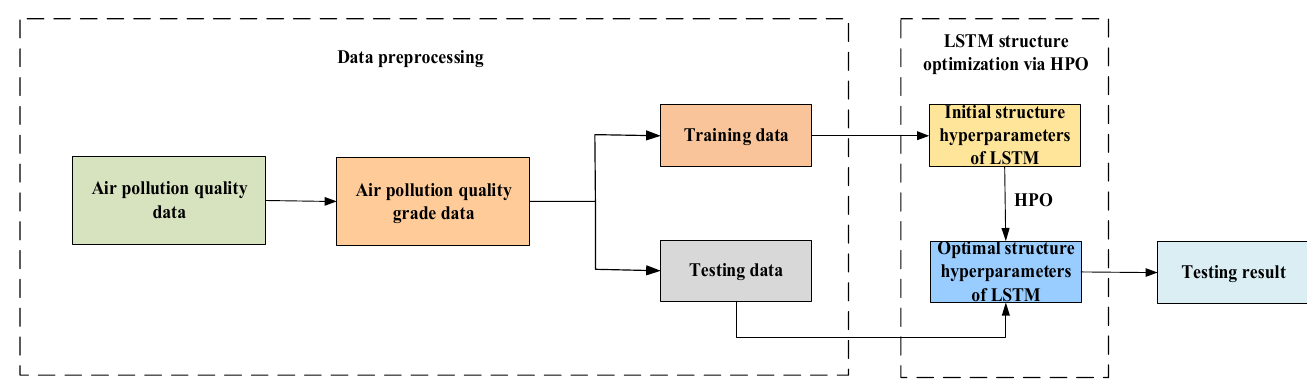
Figure 2. The flowchart of the proposed method.